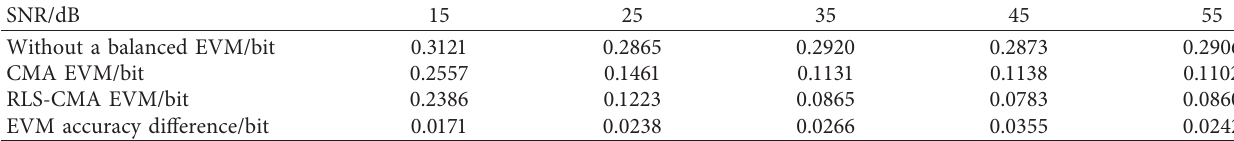
Table 4: EVM values obtained by different blind homogeneous algorithms for the 16PSK-modulated signals.